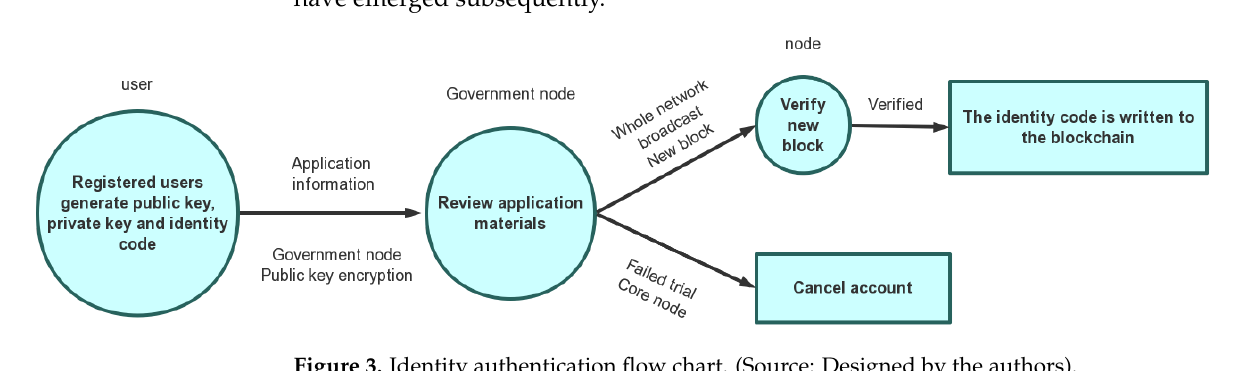
Figure 3. Identity authentication flow chart. (Source: Designed by the authors).